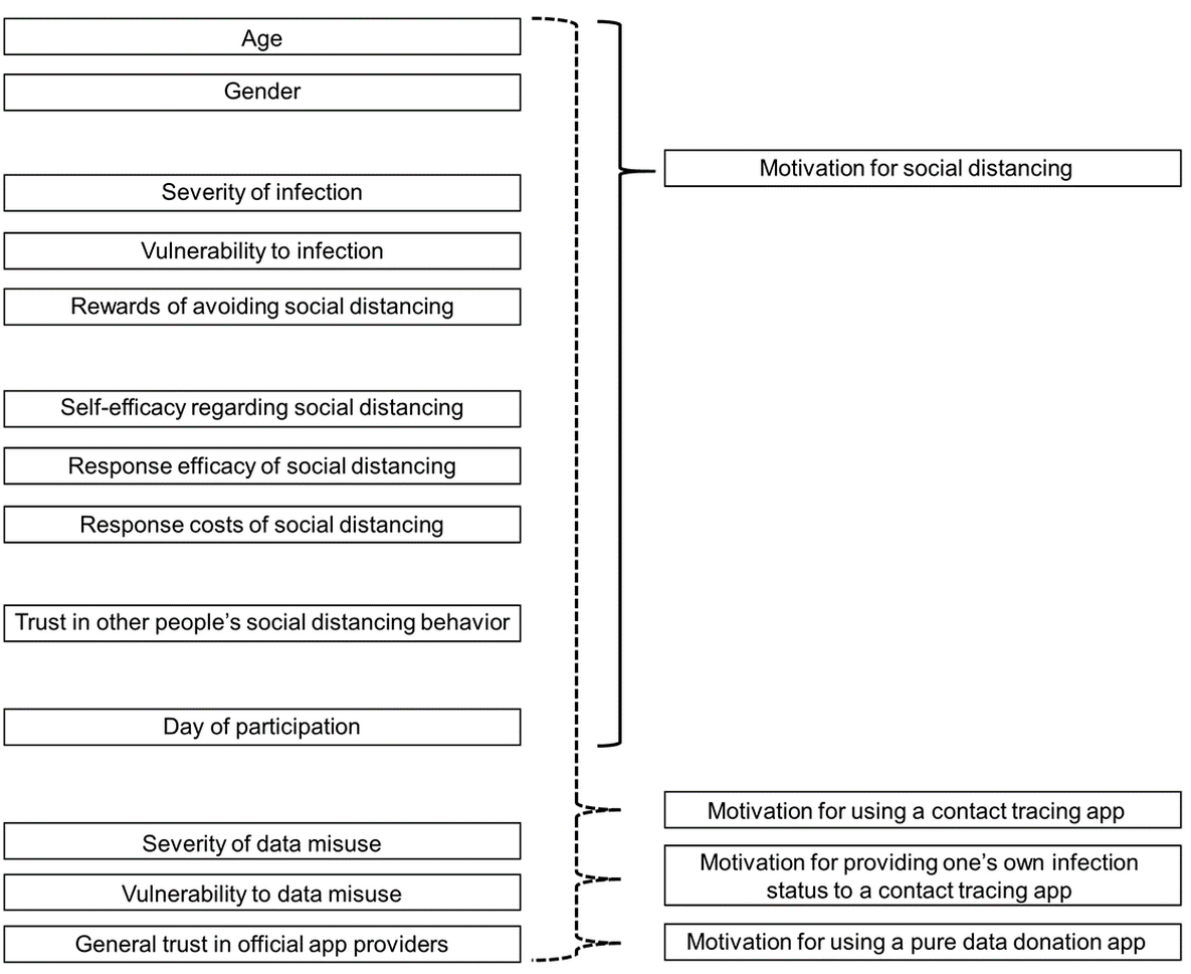
Figure 1. The regression models examined in the present study, with independent variables on the left side and dependent variables on the right